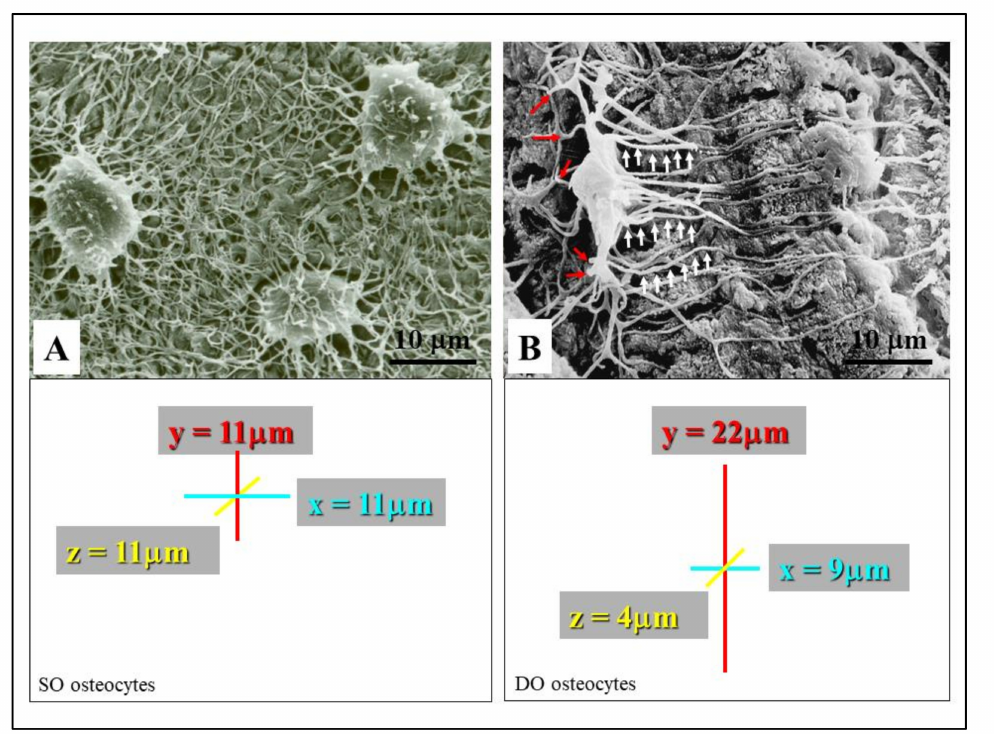
Figure 4. SEM micrographs showing the morphology of SO/DO osteocytes. ( A ) SO osteocytes have a globous shape, and their short dendrites radiate all around the cell body. ( B ) DO osteocytes display an almond-like shaped cell body and two different types of cytoplasmic processes: the short “mineral-facing” dendrites (red arrows) and the long/slender “vascular-facing” dendrites (white arrows). The square areas show the mean values of osteocyte cell body axes; the almost spherical morphology of SO osteocytes with respect to the triaxial ellipsoidal shape of the DO osteocytes can be